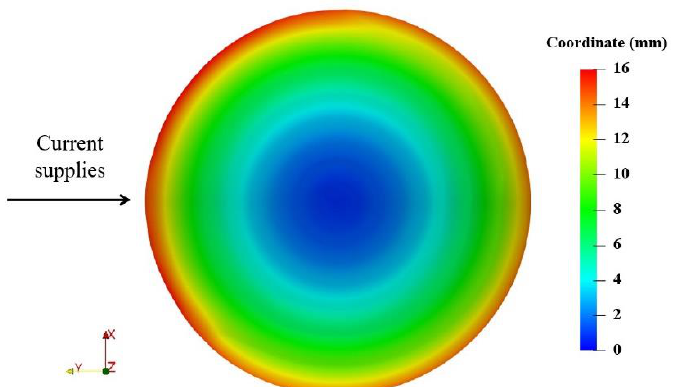
Figure 8. Top view of 3D interface shape. The color shows the vertical position distribution of the solid–liquid interface. The position of the bottom of the interface is regarded as 0 mm. The deflection of the interface is 16 mm.